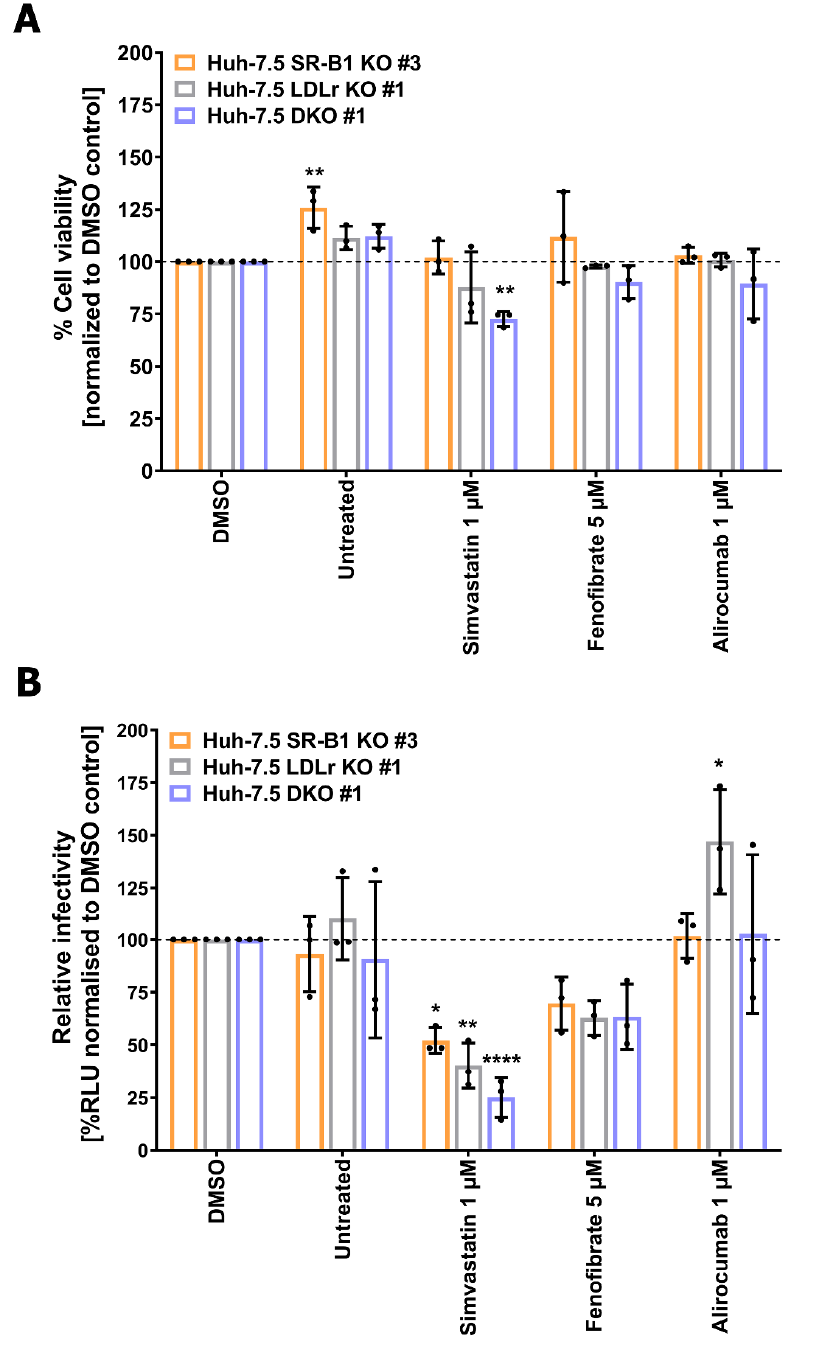
Figure 5. Lipid-lowering drugs affect HCV infection of lipoprotein receptor-deficient cell lines. Drug-induced cell cytotoxicity of lipoprotein receptor-deficient cell lines ( A ). Huh-7.5 derived SR-B1 KO #3 (light orange bars). LDLr KO #1 (grey bars) and DKO #1 (light blue bars) were treated with 1 µM simvastatin, 5 µM fenofibrate or 1 µM alirocumab for 96 h. Cell viability was determined by MTT Assay. ( B ) HCVcc infection of KO cells ( B ). SR-B1 KO #3, LDLr KO #1, and DKO #1 were treated with indicated drugs 24 h before infection with an FLuc reporter GT2a HCV virus (Fluc-Jc1) in the presence of the compounds or solvent control. 4 h later, virus was removed and drugs applied for extra 72 h before cell lysis and FLuc measurement. FLuc activities were normalized to DMSO control. Graphs represent 3 independent experiments performed in triplicates. Bars show the average and error bars in SD. Black dots plot individual values. Multiple comparison two-way ANOVA with a post hoc Dunnett correction was performed for statistical analysis ( α = 0.05, DF = 40). * p ≤ 0.05; ** p ≤ 0.01; **** p ≤